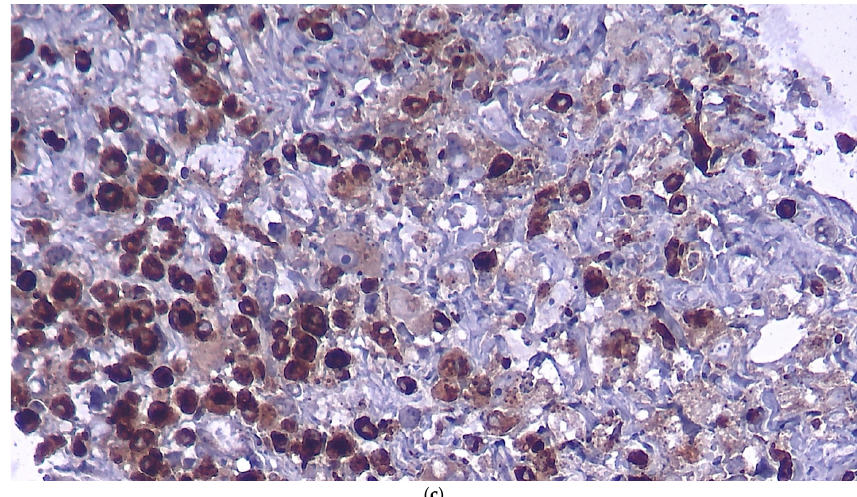
Figure 3. Histopathologic examination in regular H&E staining ( a ) , immunostaining for S100 ( b ) and for CD68 ( c ).